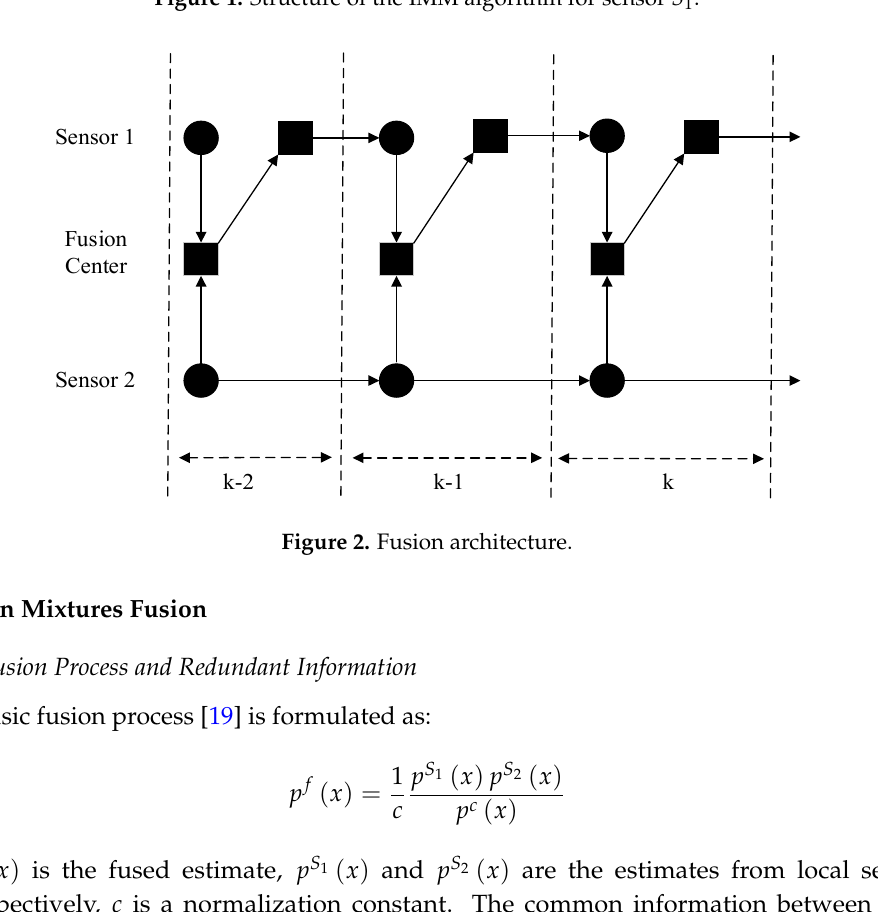
Figure 1. Structure of the IMM algorithm for sensor S 1 .